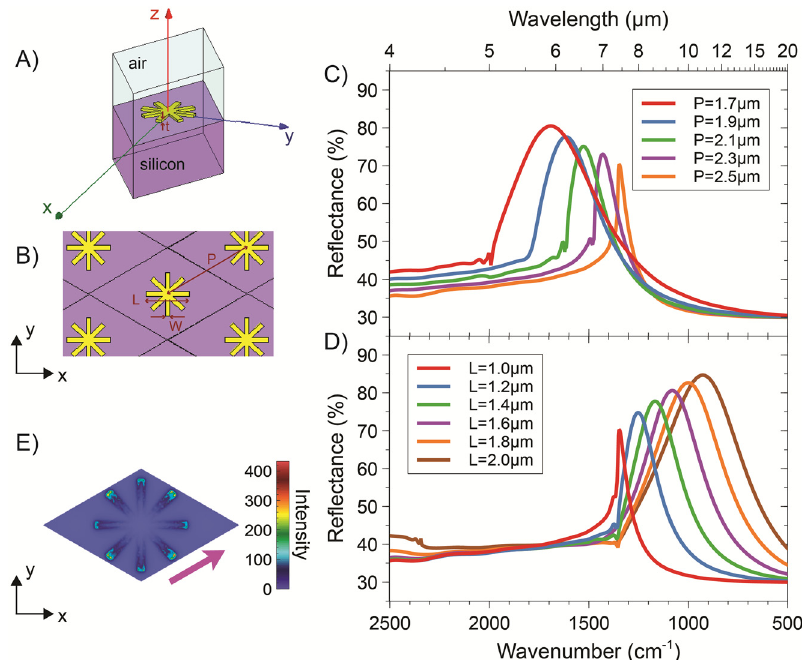
(SEM) images of two representative CS- and SS-type pixels, respec- tively, with parameters detailed in the caption.